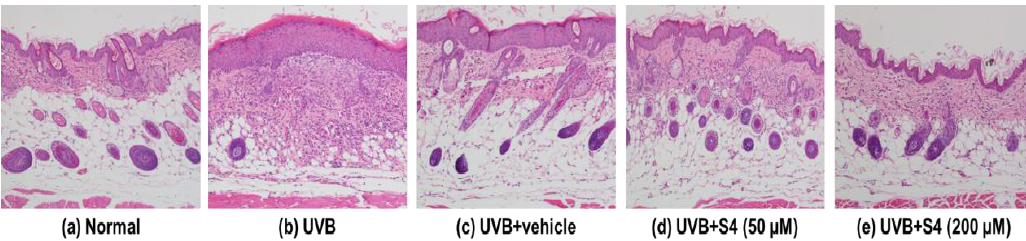
Figure 12. Light micrographs of histological sections stained with hematoxylin and eosin (H&E) of hairless mice.